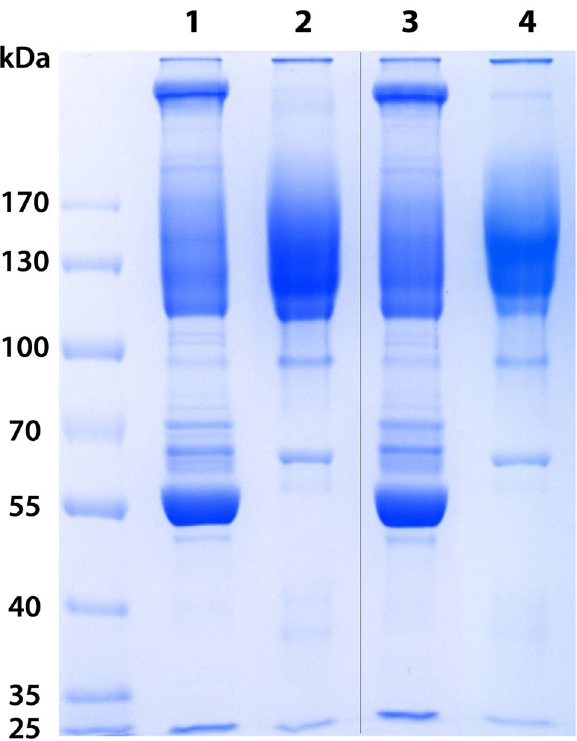
Figure 3. SDS-PAGE analysis of pools of plasma and final anti-S1 and anti-Mix formulations. Lane 1: Hyperimmune pool of plasma anti-S1; Lane 2: Anti-S1 formulation; Lane 3: Hyperimmune pool of plasma anti- Mix; Lane 4: Anti-Mix formulation. Samples (20 µg) were loaded in a 7.5% polyacrylamide gel in the presence of SDS and run under non-reducing conditions. The gel was stained with Coomassie Blue. The original gel was cropped; the full-length gel is presented in Supplementary Fig.